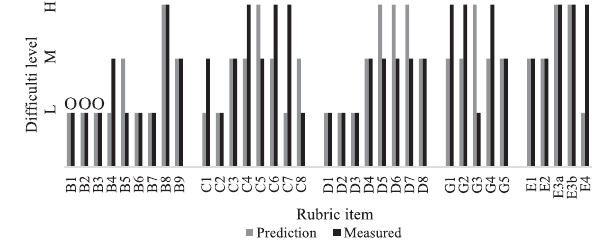
FIG. 6. Comparison of our predictions and the measured difficulties of students. The difficulty levels are as described in the text. The labels O indicate the overridden values, as described in the